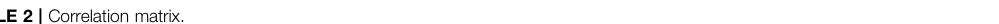
TABLE 2 | Correlation matrix. This table presents the correlations between main variables in two separate sample periods. The DC, LC, and CD are short for Development capability, Leverage condition, and CEO duality, respectively. For the de fi nitions of variables refer to Appendix A . P -values are in